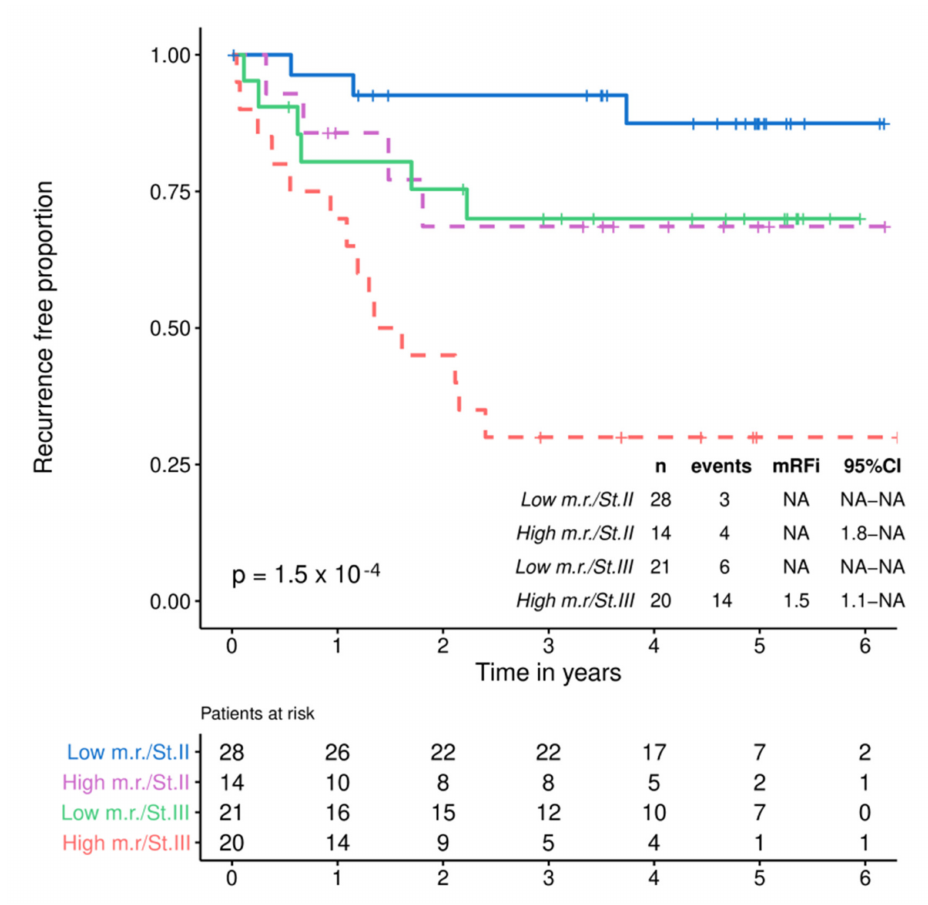
Figure 6. RFI by metabolomic risk in stage II and III. The prognostic effect of the metabolomic classifier was independent of the stage of disease as shown by the multivariate analysis (Table 4). Table 4. Multivariate